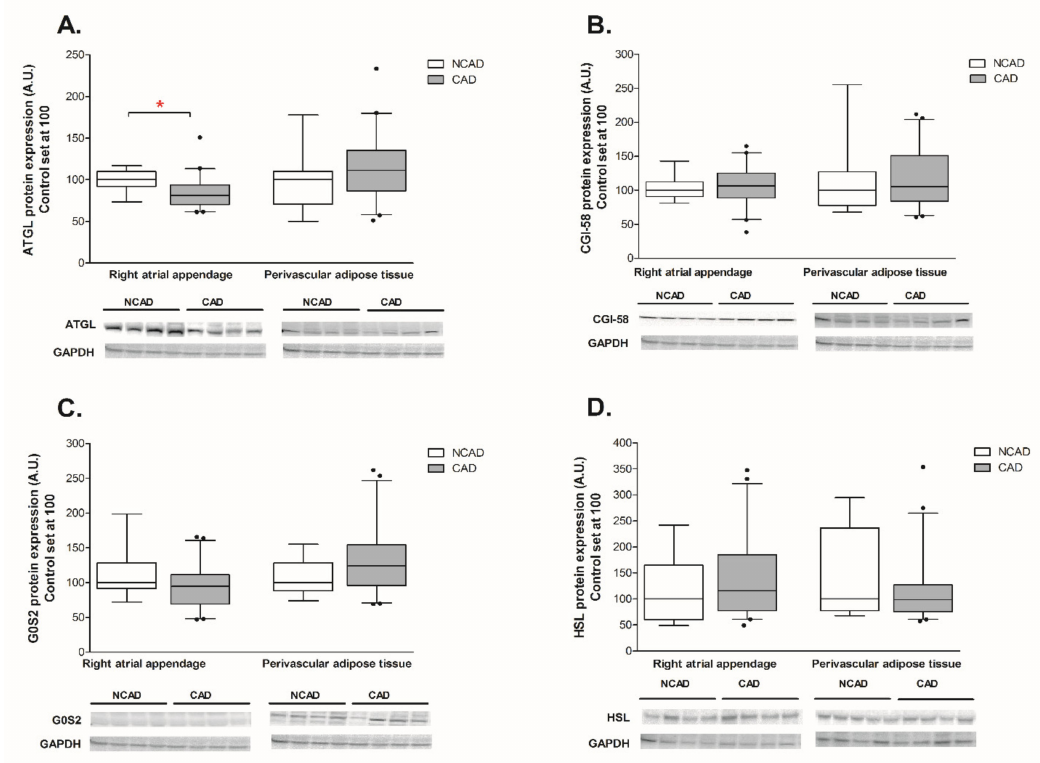
Figure 1. Myocardial and perivascular adipose tissue proteins expression of ( A ) adipose triglyceride lipase (ATGL), ( B ) comparative gene identification 58 (CGI-58), ( C ) G0 / G1 switch gene 2 (G0S2), ( D ) hormone-sensitive lipase (HSL) in the coronary atherosclerosis (CAD, n = 42) and control (NCAD, n = 11) patients. Representative bands of WB analysis were shown. The inner horizontal line of a box represents the median. Box boundaries: 25–75 percentile; whiskers 5–95 percentile. Data are expressed as median ± SEM. For the sake of clarity, the control group median was set at 100, and the CAD group was scaled with respect to NCAD. * p < 0.05 vs. control